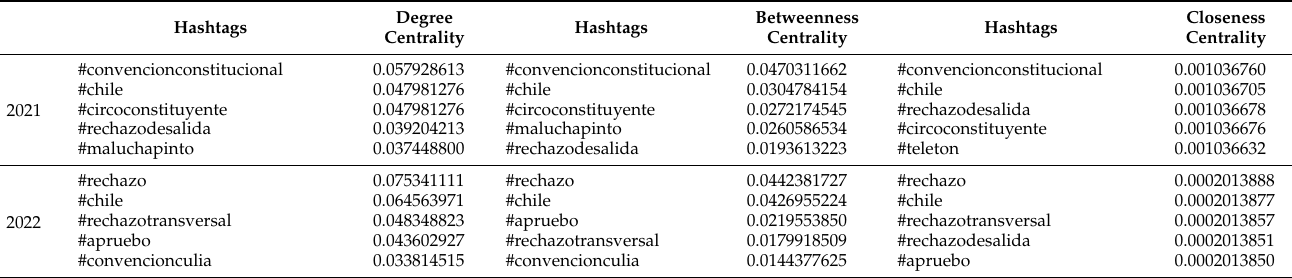
Table 7. Five highest hashtags in local network metrics for “Vamos por Chile”.